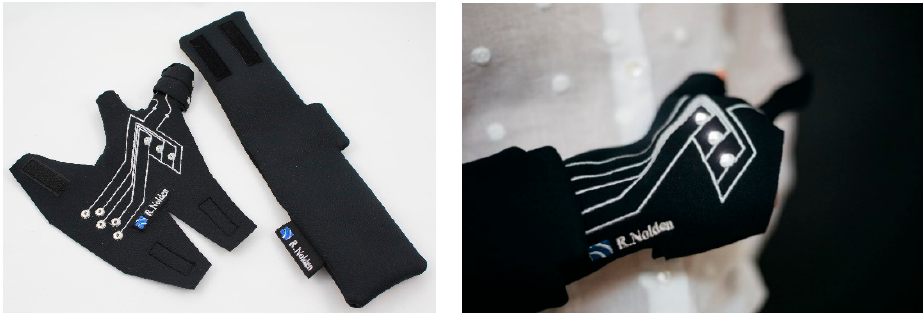
Figure 3. Smart glove and cuff; when forming a wrist, the LEDs light up giving feedback on the intensity of the bending of single